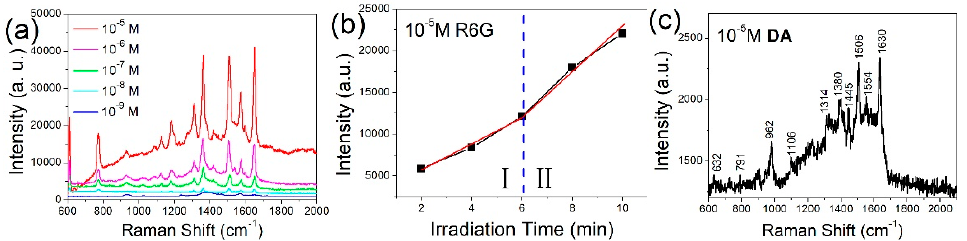
Figure 5. ( a ) Surface-enhanced Raman spectroscopy (SERS) spectra of Rhodamine (R6G) solutions with different concentrations on silicon nanowires coated with silver nanoparticles. ( b ) Raman intensity at 612 cm –1 for 10 –5 M R6G as a function of UV irradiation time. ( c ) Raman spectrum of 10 –5 M dopamine hydrochloride solution. The laser power for dopamine (DA) Raman measurement was 0.01 mW.